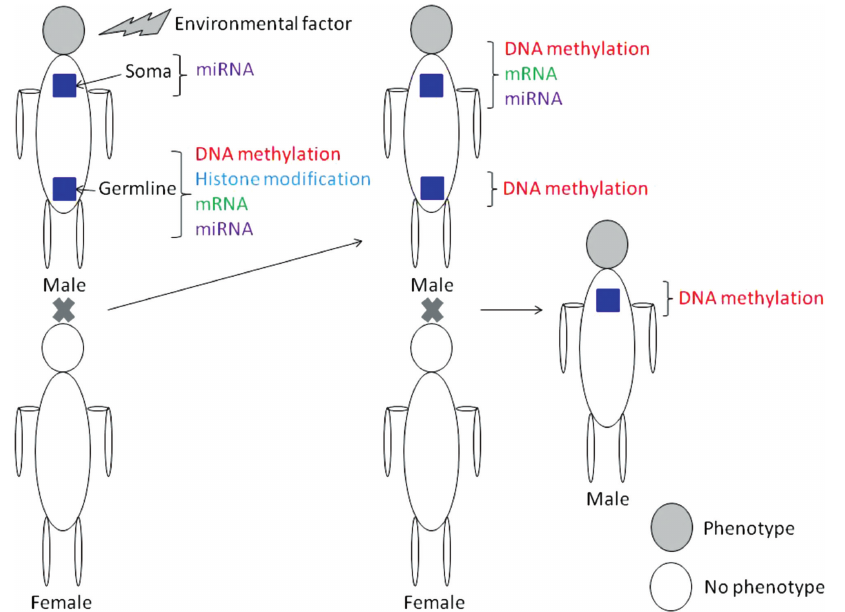
Figure 1: Existential evidence of transgenerational inheritance. Cumulative findings of various studies reported so far involving paternal exposure and inheritance via male line are illustrated. Note inherit- ance of the phenotypic effect and its epigenetic